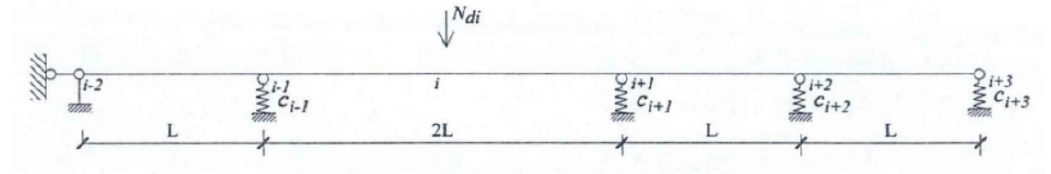
Fig. 6. Schematic diagram of simplified calculation when arch bridge suspended